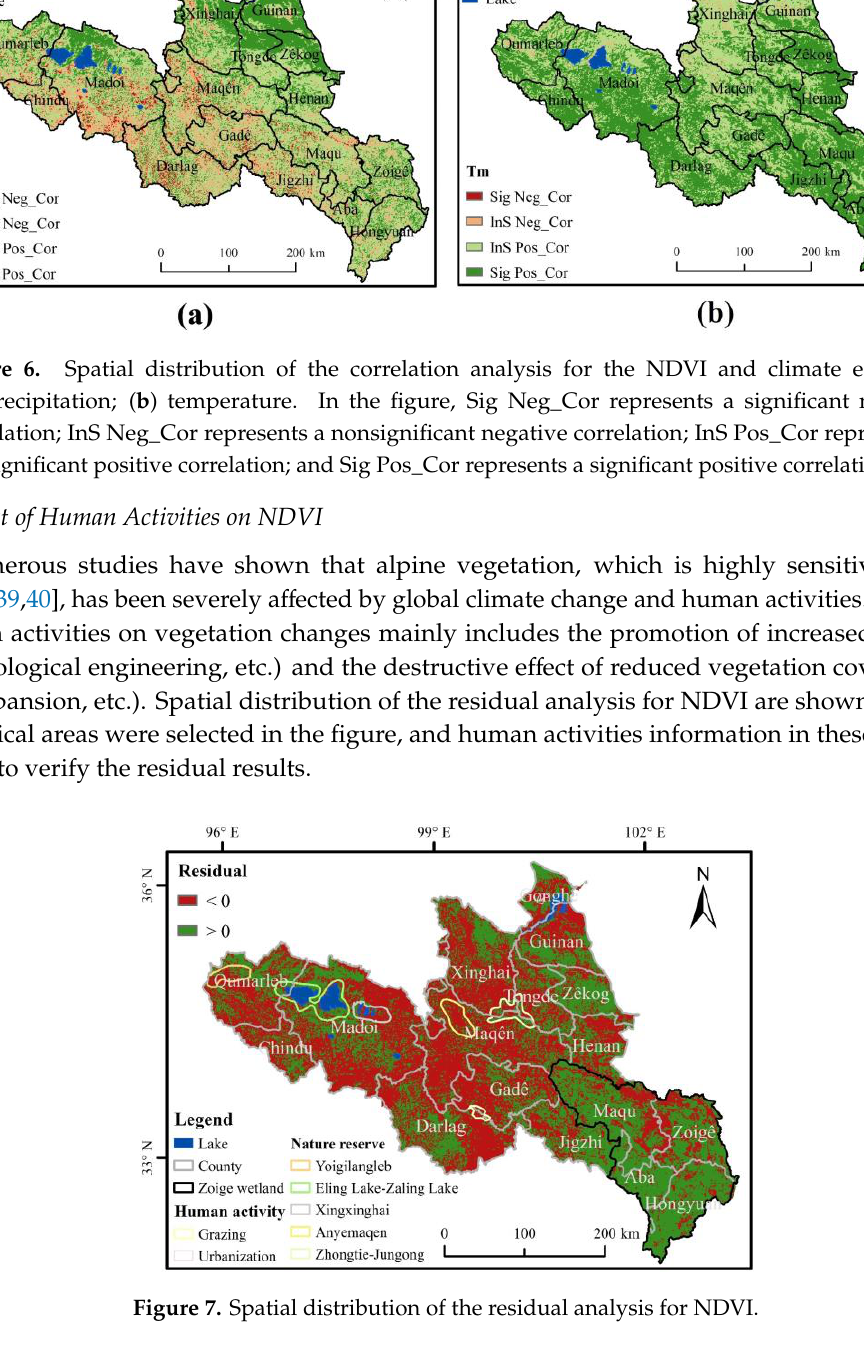
Figure 7. Spatial distribution of the residual analysis for NDVI.